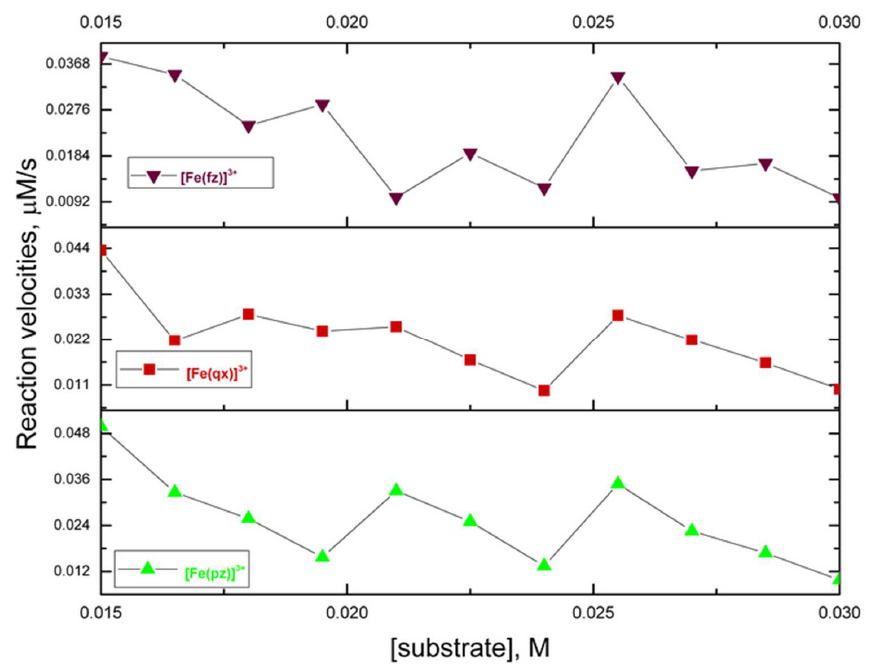
Figure 4. Initial rate results on the oxidation reaction of DTBC to DTBQ and catalyzed by [Fe (pz)] 3+ , [Fe (qx)] 3+ , and [Fe (fz)] 3+ .